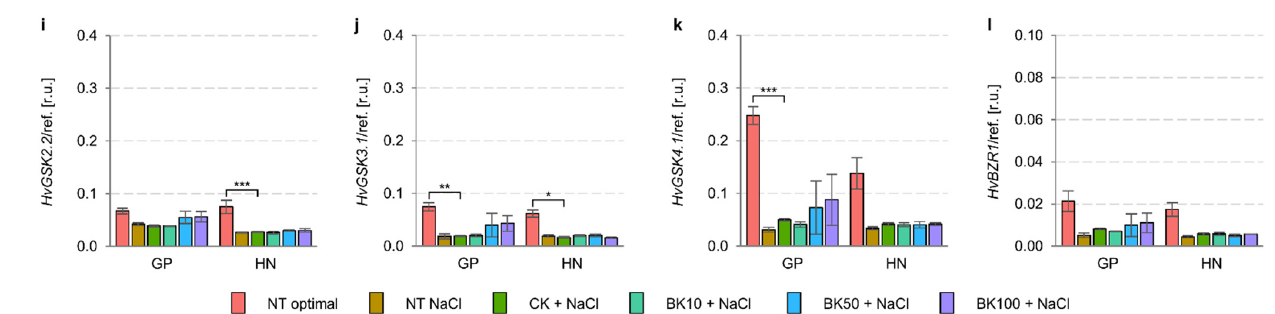
Figure 10. Treatment with bikinin resulted in expression changes in barley grown under normal and salt stress conditions. Expression profile of genes controlling consecutive stages of BR’s biosyn- thetic ( a ) and signaling pathways ( b – l ) after bikinin treatment with 10 µ M, 50 µ M, and 100 µ M (BK10, BK50, and BK100, respectively) compared to controls with 0.11% DMSO (CK) used as a background for solvent solutions for each bikinin concentration. Non-treated plants (NT) were used as a control for the 0.11% DMSO treatment. The values in ( a – l ) represent the mean and standard error for three bi- ological replicates. The results of the HSD Tukey test are presented in Table S7 (*, p ≤ 0.05; **, p ≤ 0.01; ***, p ≤ 0.001). Table 7. Results of two-way ANOVA for two barley genotypes (Golden Promise and Haruna Nijo) grown in two conditions (control conditions and salt stress induced by 150 mM sodium chloride) calculated for genes controlling brassinosteroid (BR) biosynthesis ( HvDWF4 ) and the BR signaling pathway ( HvBRI1 , HvBAK1 , HvBSU1 , HvGSK1.1 , HvGSK1.2 , HvGSK1.3 , HvGSK2.1